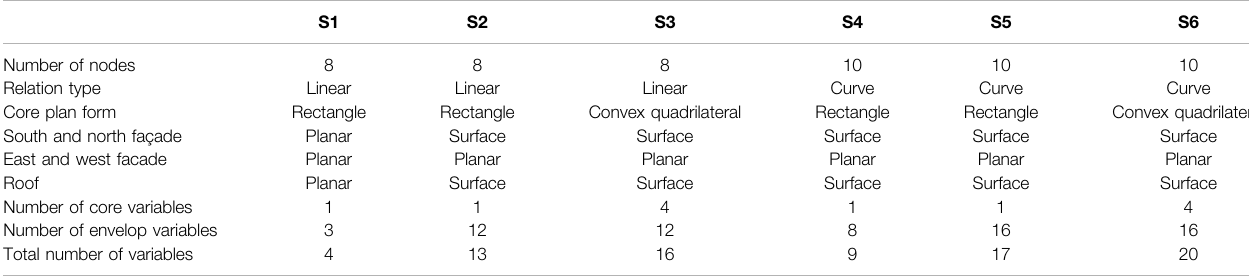
TABLE 1 | Summary of the six shapes.